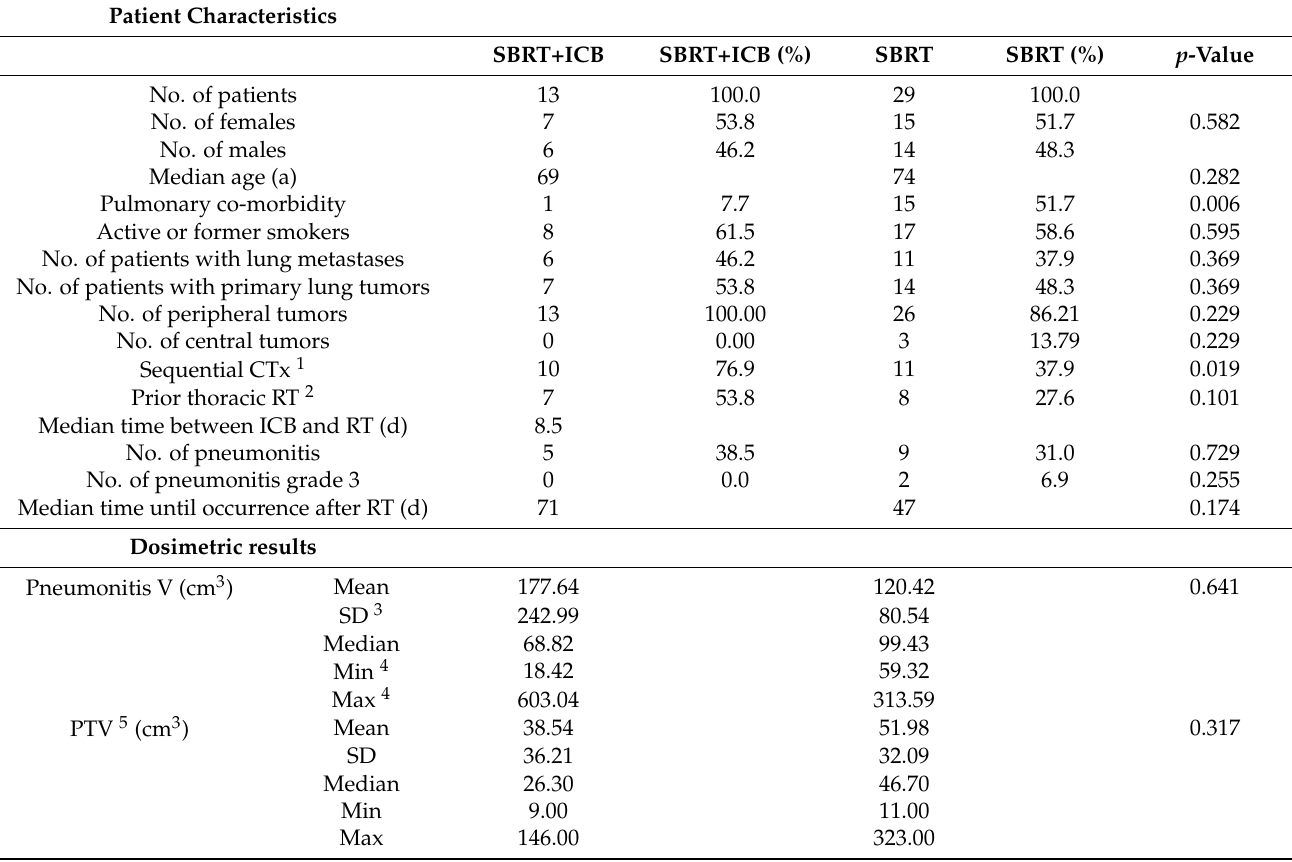
Table 1. Patient characteristics and dosimetric data. Doses are reported in 2 Gy fractions equivalent doses